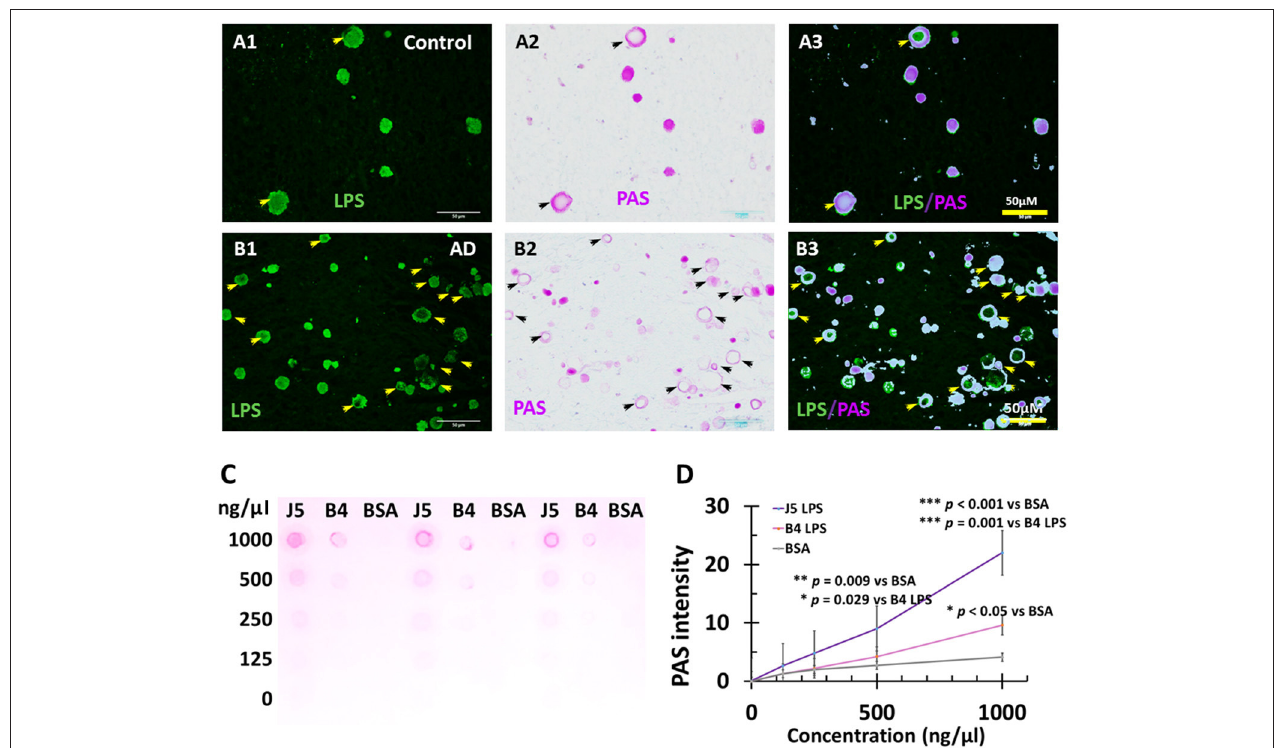
FIGURE 9 | PAS staining of LPS in Corpora amylacea of AD and aging brains, and PAS staining of purified LPS. In control, PVWM LPS (A1) and PAS (A2) were co-localized (A3) . IN AD PVWM there were more LPS stained vacuoles (B1) and PAS-stained Corpora amylacea (B2) which were mostly co-localized (B3) . Most but not all LPS stained vesicles were PAS positive and therefore were Corpora amylacea (CA). PAS stained both E. coli J5 LPS and E. coli O111:B4 LPS at the higher concentrations (1,000 ng/ µ l and 500 ng/ µ l) with much greater staining intensity for E. coli J5 LPS than E. coli O111:B4 LPS at the same concentrations (C,D) . When the LPS concentrations were 250 ng/ µ l, PAS only stained E. coli J5 LPS but not the E. coli O111:B4 LPS. However, the difference was not significant. When the LPS concentrations were 125 ng/ µ l, PAS did not stain either E. coli J5 LPS or E. coli O111:B4 LPS. Note: LPS, lipopolysaccharide; PAS, Periodic acid–Schiff, a marker for CA; J5, E. coli J5 LPS; B4, E. coli O111:B4 LPS; AD, Alzheimer’s disease; Bar = 50 µ